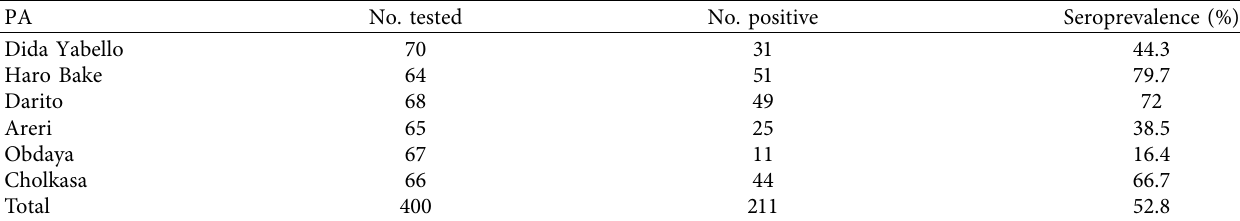
Table 1: Overall seroprevalence of T. gondii infection in small ruminants in six PAs of Yabello. PA